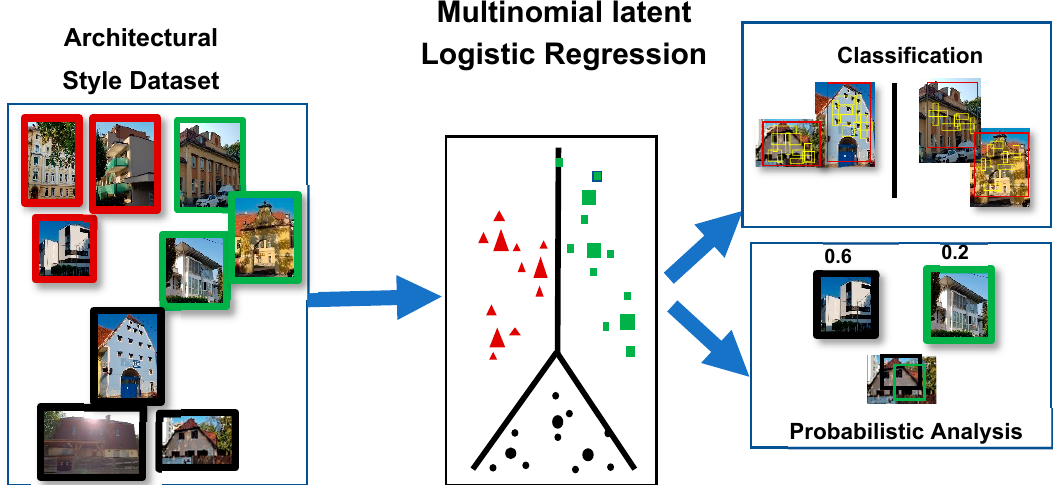
Figure 7. Schematic illustration (our own redrawing) of an architectural style classification using the Multinomial Latent Logistic Regression (MLLR) [37].